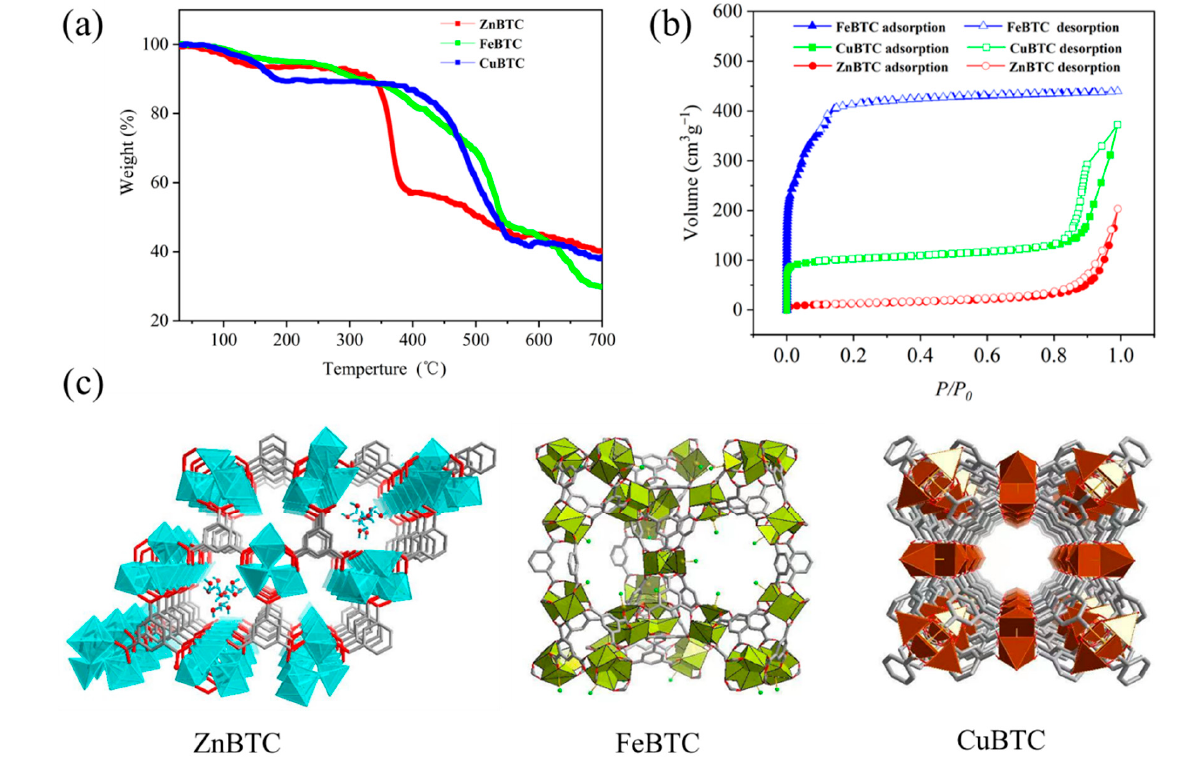
Figure 2. The TGA curve ( a ), N 2 adsorption − desorption isotherms ( b ) and the crystal character of ZnBTC, FeBTC and CuBTC ( c ).